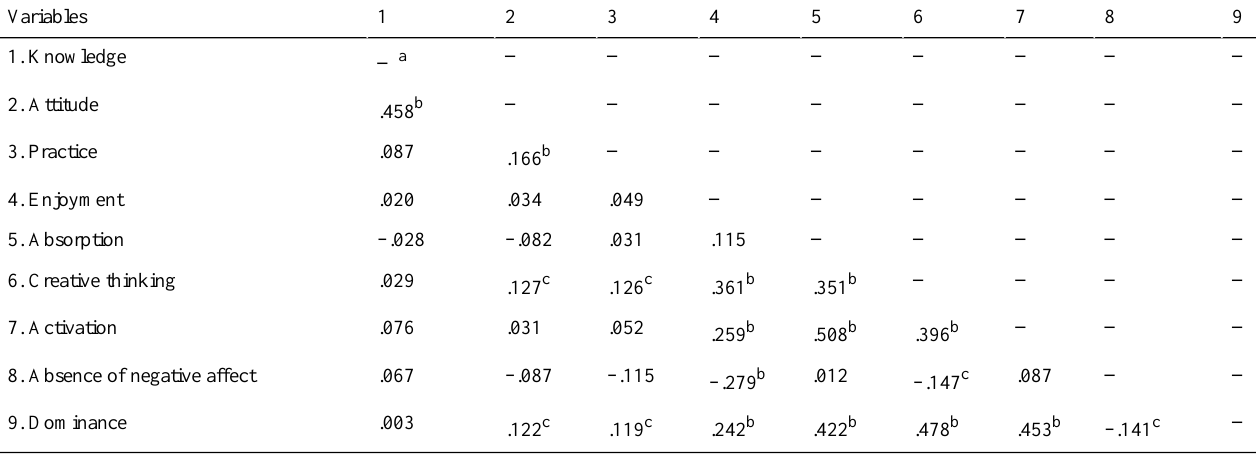
Table 6. Spearman rank correlation of gameful experience with knowledge, attitudes, and practices regarding COVID-19 (N=324). 987654321Variables ————————— a 1.